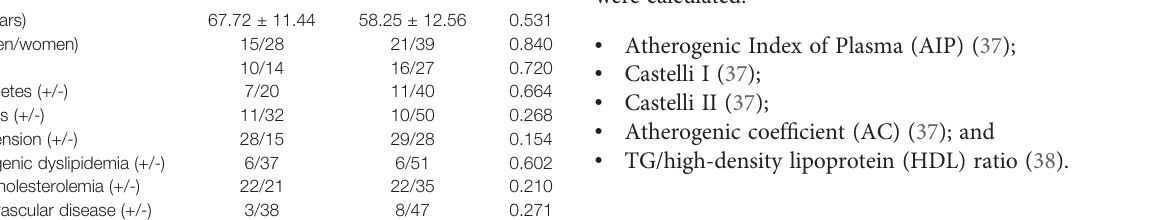
TABLE 1 | Clinical characteristics of the study group and controls.